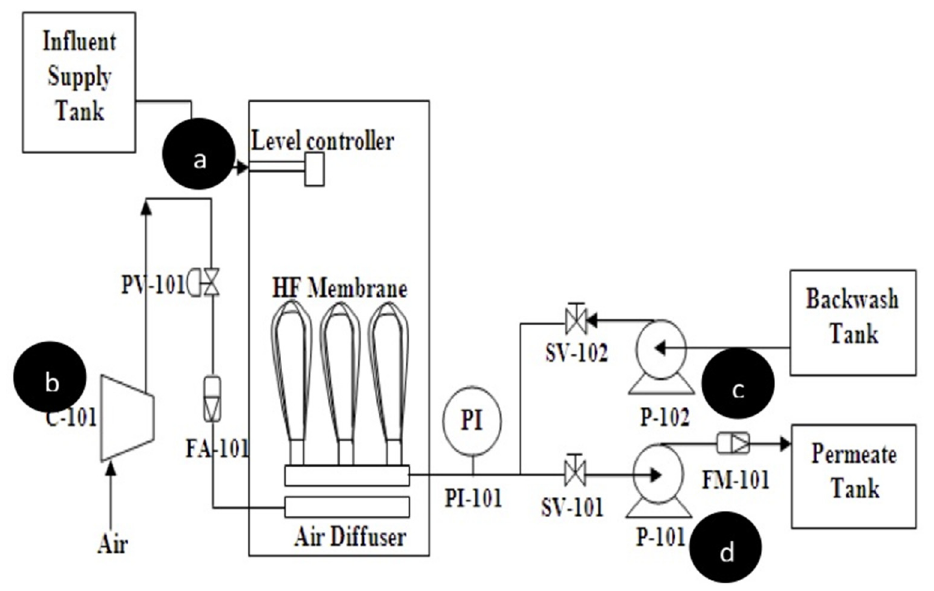
Figure 2. The schematic layout of th submerged Membrane Bioreactor (MBR) pilot plant: a —inlet stream, b —aeration stream, c —backwash stream, d —permeate stream.